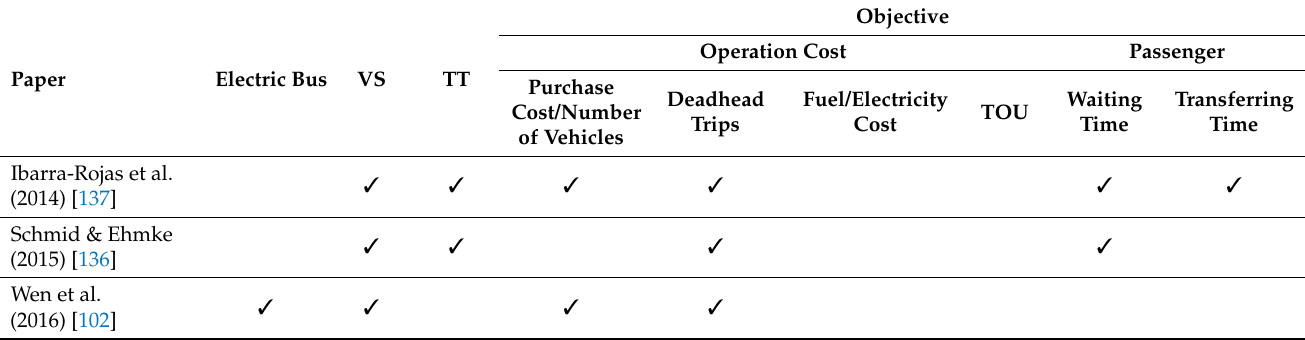
Table 6. Different studies related to the objectives of bus scheduling and